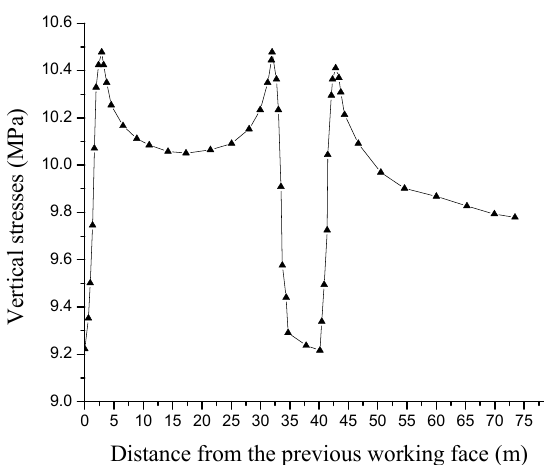
Figure 11. Vertical stresses after roadway excavation.